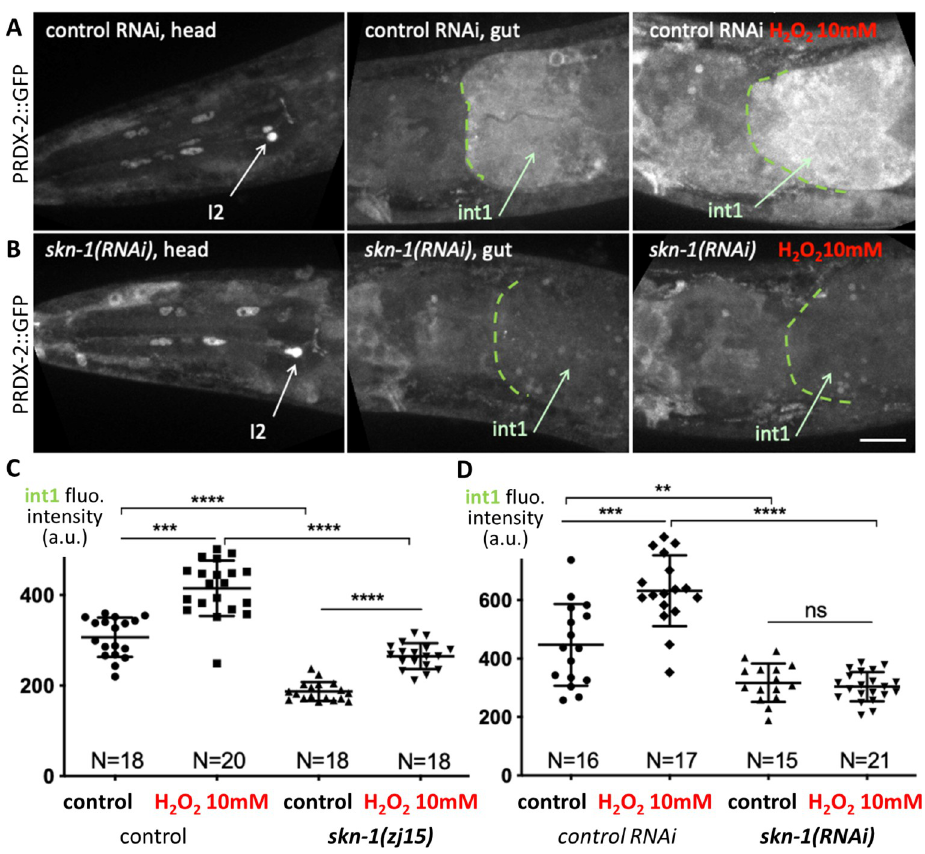
Fig 2. SKN-1 function is required for PRDX-2 expression in the gut. (A-B) Spinning-disc confocal projections of head and anterior gut of PRDX-2::GFP knock-in animals, in control RNAi (A) and in skn-1(RNAi) (B) animals. The right panel shows the foregut of a 10mM H 2 O 2 -treated animal in both genotypes. Note the low level of int1 PRDX-2:: GFP fluorescence in skn-1(RNAi) animal. (C-D) Quantification of the int1 cell fluorescence intensity in control and after a 10mM H 2 O 2 -treatment, in skn-1(zj15) mutants (C) and in skn-1(RNAi) animals (D). Bars indicate mean and SD. ns, not significant, p > 0.05; �� p < 0.01; ��� p < 0.001; ��� p < 0.0001 (t test, ANOVA). Scale bar, 20 μ m. PRDX-2 might exert a different function depending on the cell type: H O detoxification in 2 2 the foregut, triggered by SKN-1, vs . H O perception or signaling in I2 neurons. 2 2